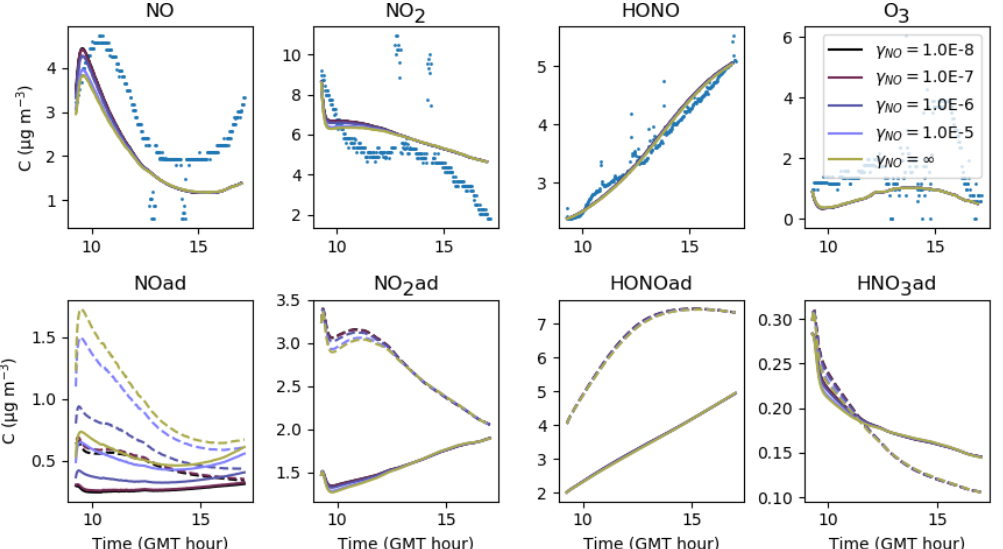
Figure 18. Gas-phase and adsorbed inorganic compounds simulated for different γ NO . The blue dots denote the experimental measurements (Experiment 3). The solid lines represent the concentrations in the sunlit box and the dashed lines the concentrations in the shaded box.